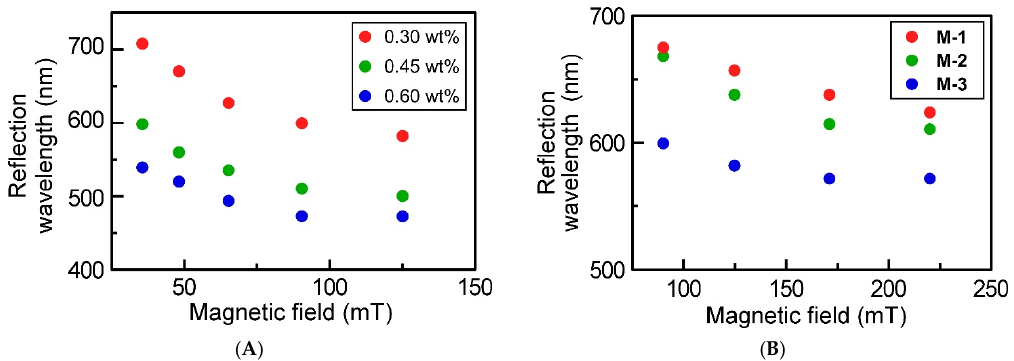
Figure 5. ( A ) Changes in the reflection peak wavelengths of aqueous suspensions of M-3 , whose concentrations were adjusted to 0.30 wt%, 0.45 wt%, and 0.60 wt%, as a function of the external magnetic field in the range between 36 mT and 125 mT. ( B ) Changes in the reflection peak wavelengths of aqueous suspensions of M-1 , M-2 , and M-3 at same concentration of 0.30 wt% as a function of the external magnetic field in the range between 91 mT to 220 mT.